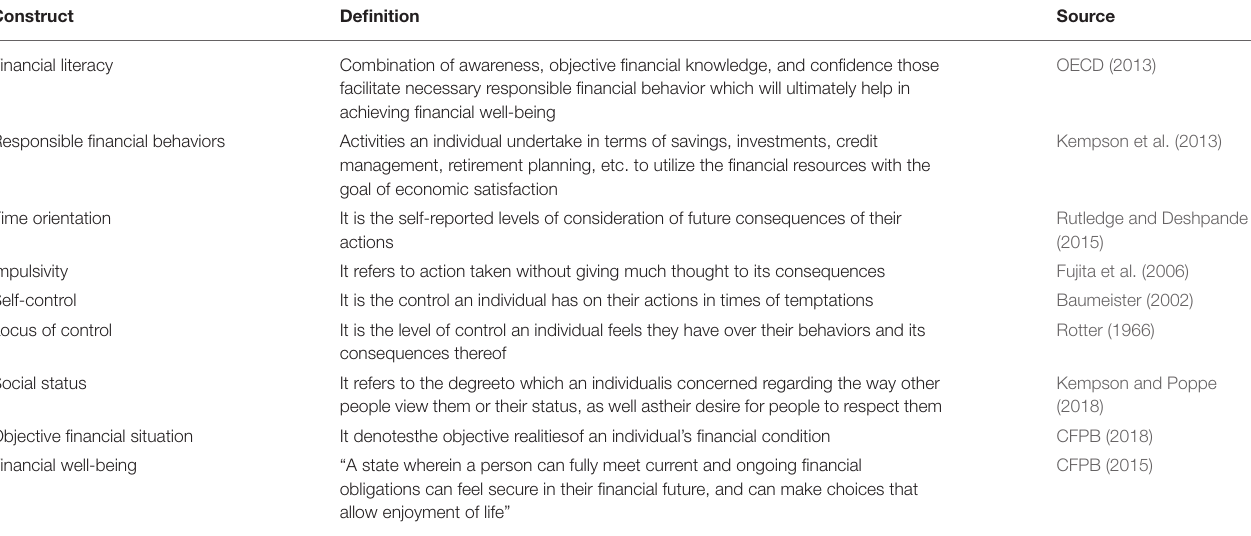
TABLE 1 | Operational